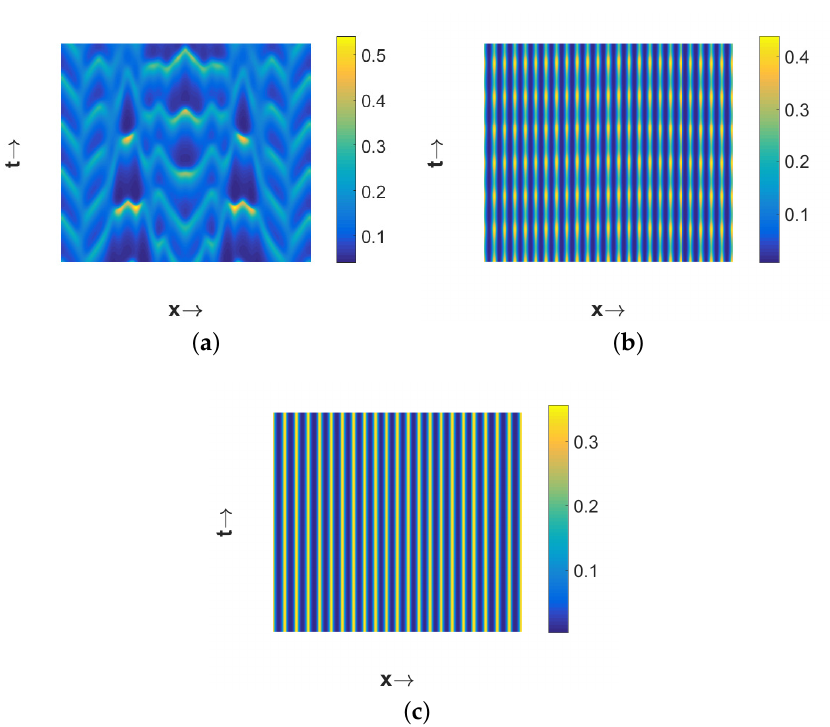
Figure 8. Plots of different types of patterns exhibited by u 1 for (cid:101) = 8.0. Three different patterns are